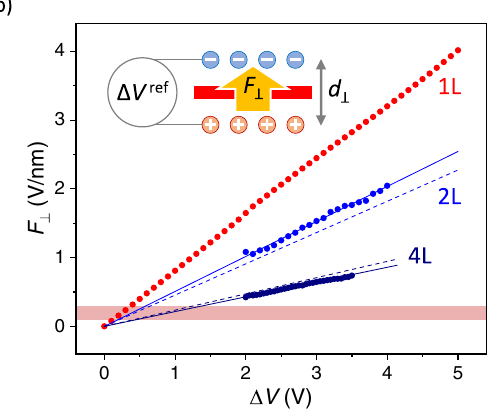
Fig. 5 | Electric fi eld through 1L, 2L, and 4L WSe 2 . a Reference voltage data from 1LWSe 2 (sample#4).Thedirectionofthesweepisindicatedbyarrows,andthered portion of the curve is used to extract the fi eld. b Perpendicular electric fi eld through1LWSe 2 extractedfromreferencevoltagedata(red datapoints)alongside the 2L and 4L WSe 2 fi eld data extracted from transport maps (blue and dark blue dots,respectively)and fi tstothesedatapoints(solidlines).Dashedlinesfor2Land